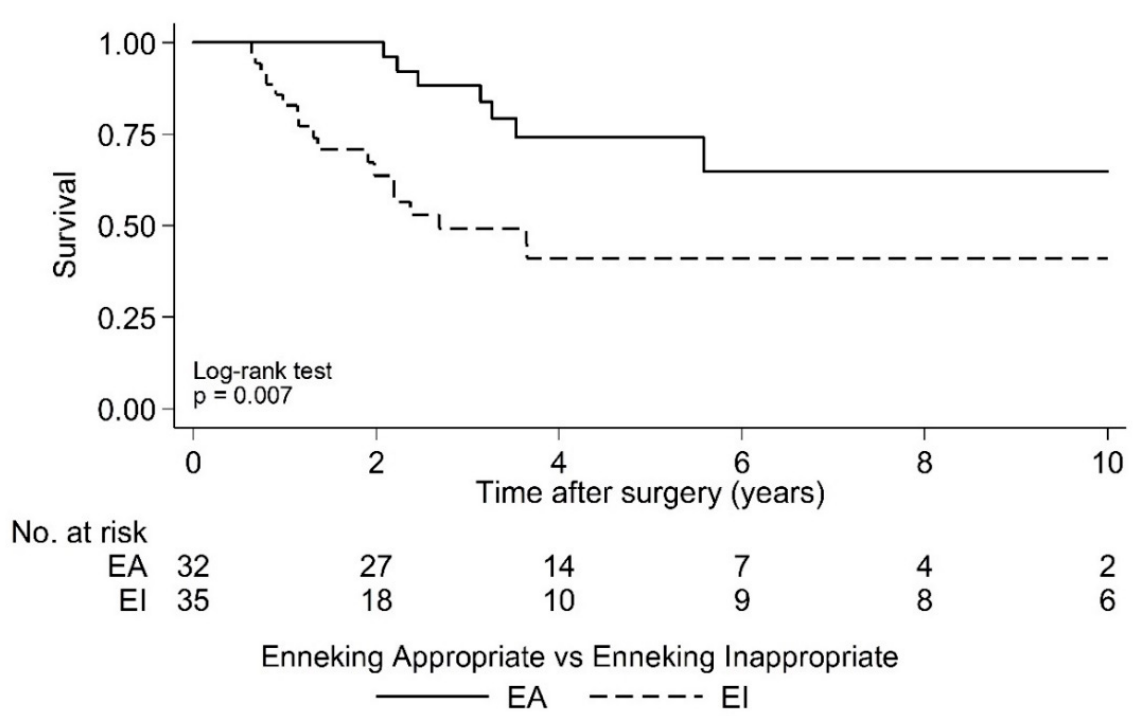
Figure 5. Kaplan-Meier analysis of overall survival following surgery by Enneking appropriateness. Table 6. Key parameters for each histotype regarding the overall number/percentage, tumor grade according to the Enneking classification, resection result, LR and OS.